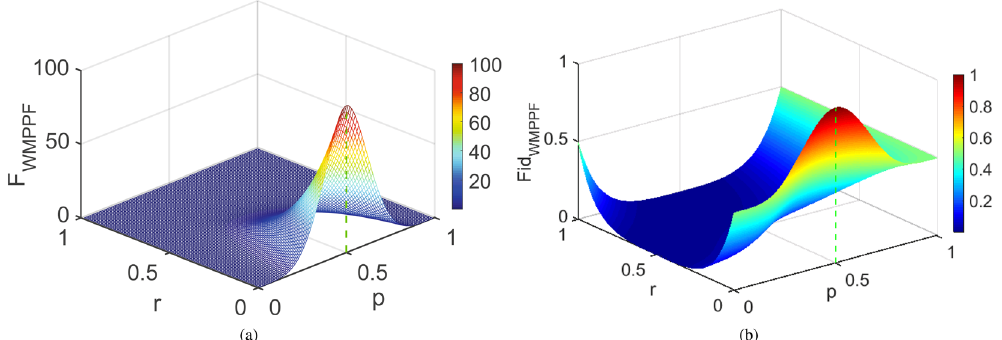
Figure 3. ( a ) Average QFI vs. p and r for WMPPF with N = 10, θ = π /2. ( b ) Average fidelity vs. p and r for WMPPF with N = 10, θ = π /2. In ( a , b ), the maximal values of F WMPPF (i.e., the maximal average QFI: F MWMPPF ) and Fid WMPPF (i.e., the maximal average fidelity: Fid MWMPPF ) are corresponding to the ridge lines of the two figures, respectively. It is clear that p = 0.5 is the optimal value for F MWMPPF and Fid MWMPPF at r = 0, while the optimal p values for F MWMPPF and for Fid MWMPPF are deviated from 0.5 with different features when r >